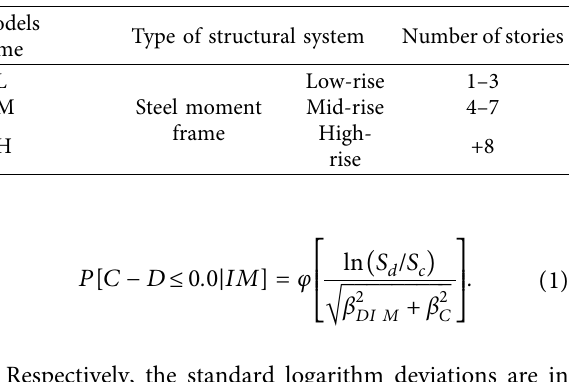
Table 4: Different types of Steel moment frames in HAZUS MH- MR4